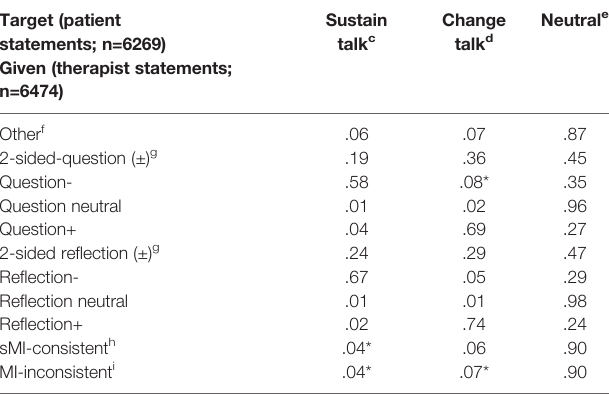
TABLE 6 | Conditional probabilities ab